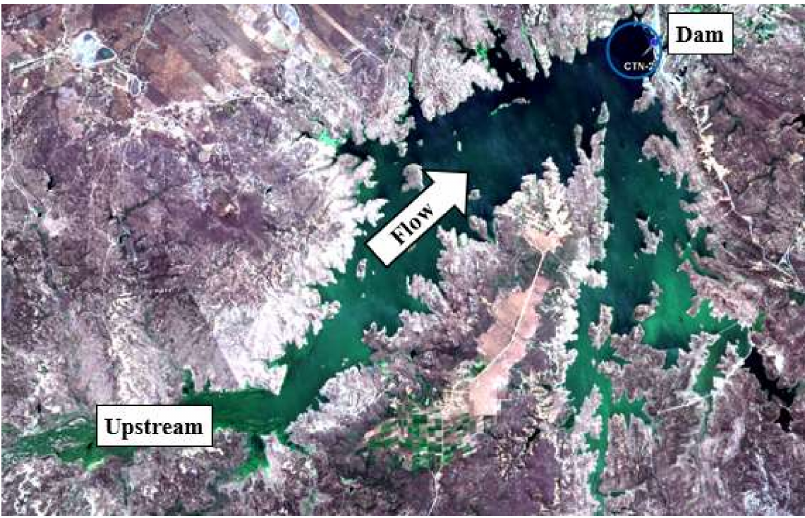
Figure 8. Hydrological flow in the Castanh ã o reservoir and location of the reservoir